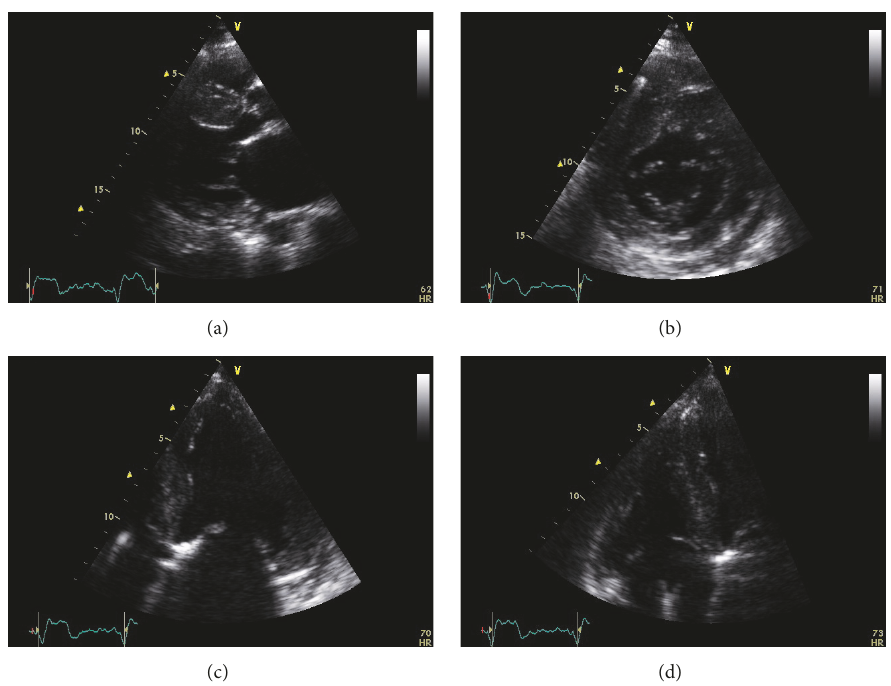
Figure 7: Echocardiographic images from a patient with advanced Anderson-Fabry disease and end-stage renal failure. Parasternal long axis (a), short axis (b), and apical four-chamber view (c). There is left ventricular hypertrophy, more pronounced at the interventricular septum. There is also thickening of the right ventricular free wall apparent at the modified apical four-chamber view